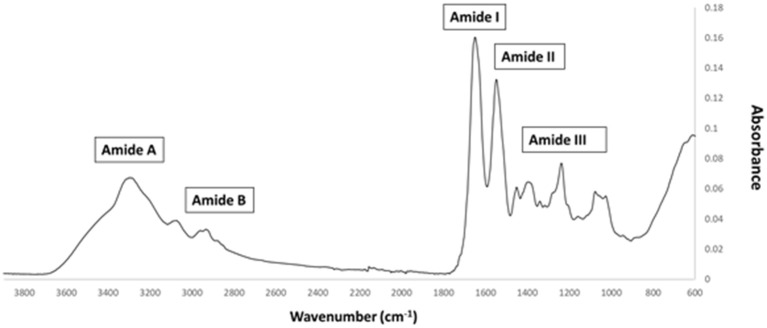
FTIR spectrum of collagen from R. pulmo jellyfish. Attenuated total reflection (ATR)–Fourier–transform infrared spectroscopy (FTIR) spectra reveal the collagen bands in R. Pulmo collagen, with collagen I specific Amide pattern.